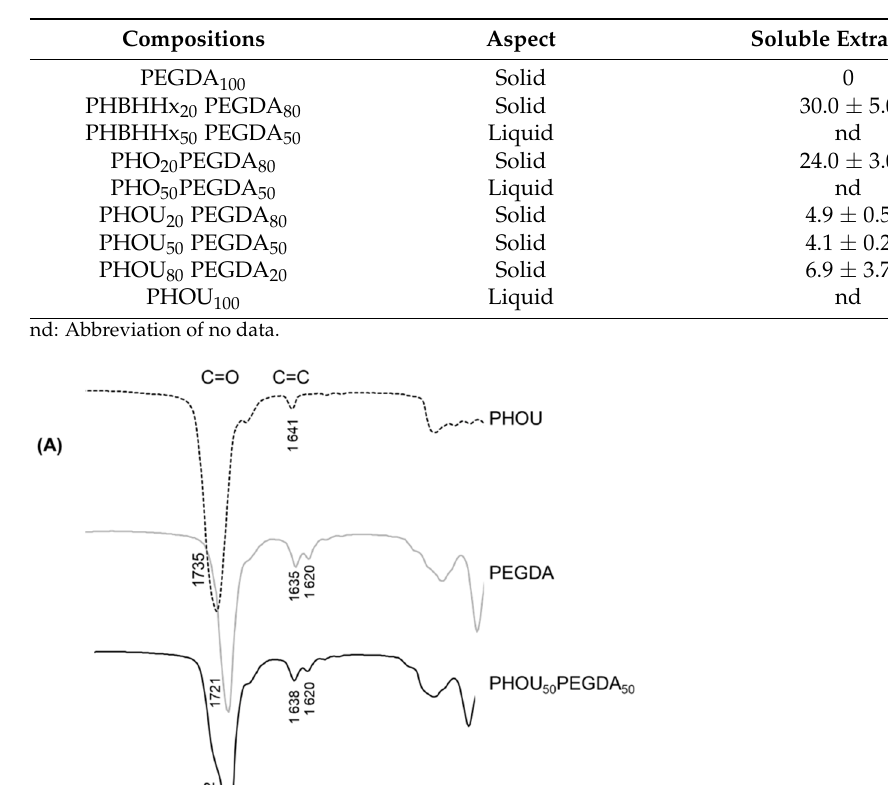
Table 1. Gel formation of PHA x PEGDA 1 − x networks after 300 s of photoirradiation in the presence of DMPA and PHAs at 100 g · L − 1 .